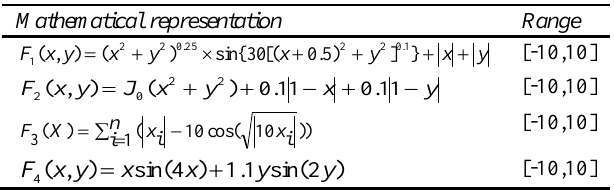
Table 1.Benchmark functions Algorithmic parameters for all algorithms are illustrated in Table 2.